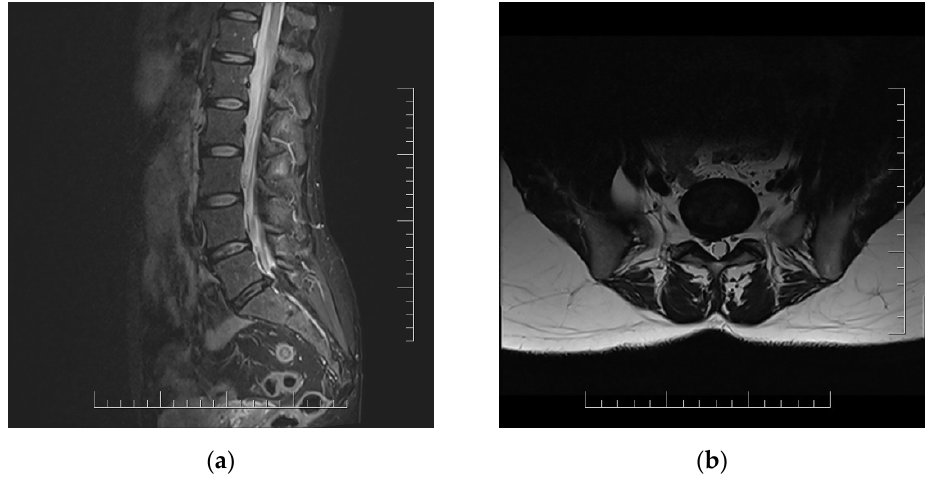
Figure 1. MRI scans of lumbar spine in 51 year old woman with persistent lumbar pain and radicular irritation of right L5 and S1 in chronic long COVID with correlation with L5/S1 disc herniation.